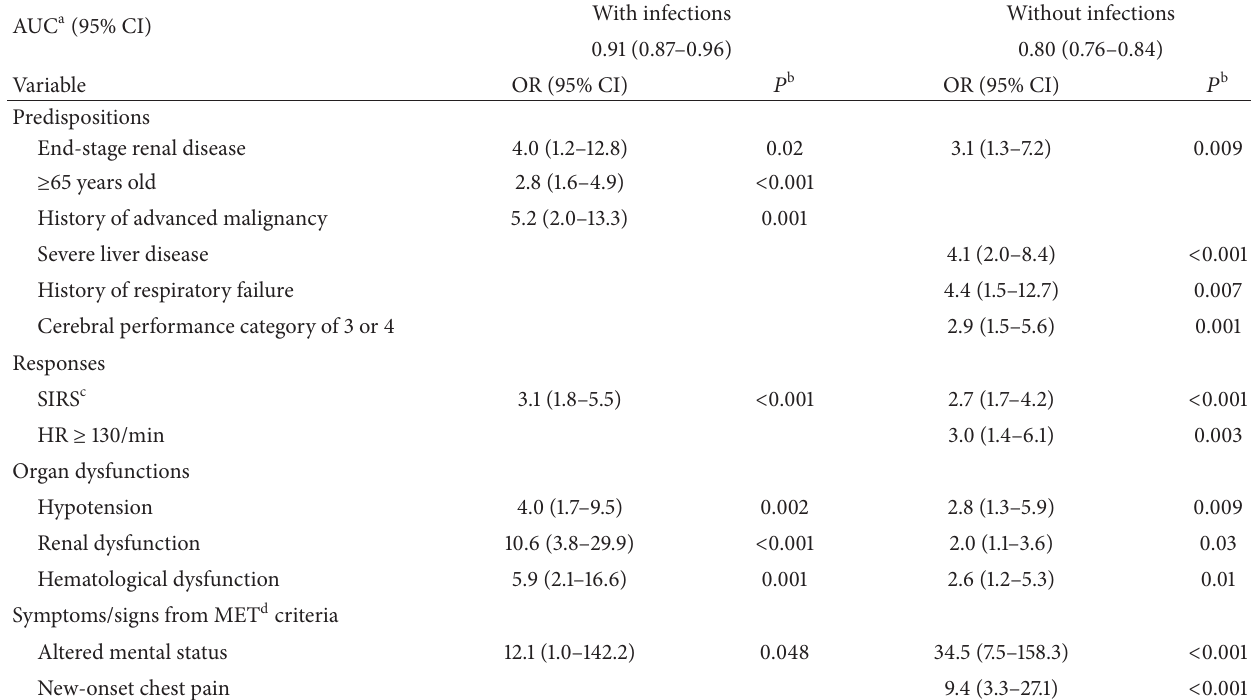
Table 4: Multiple logistic regression analyses for risk of unplanned ICU